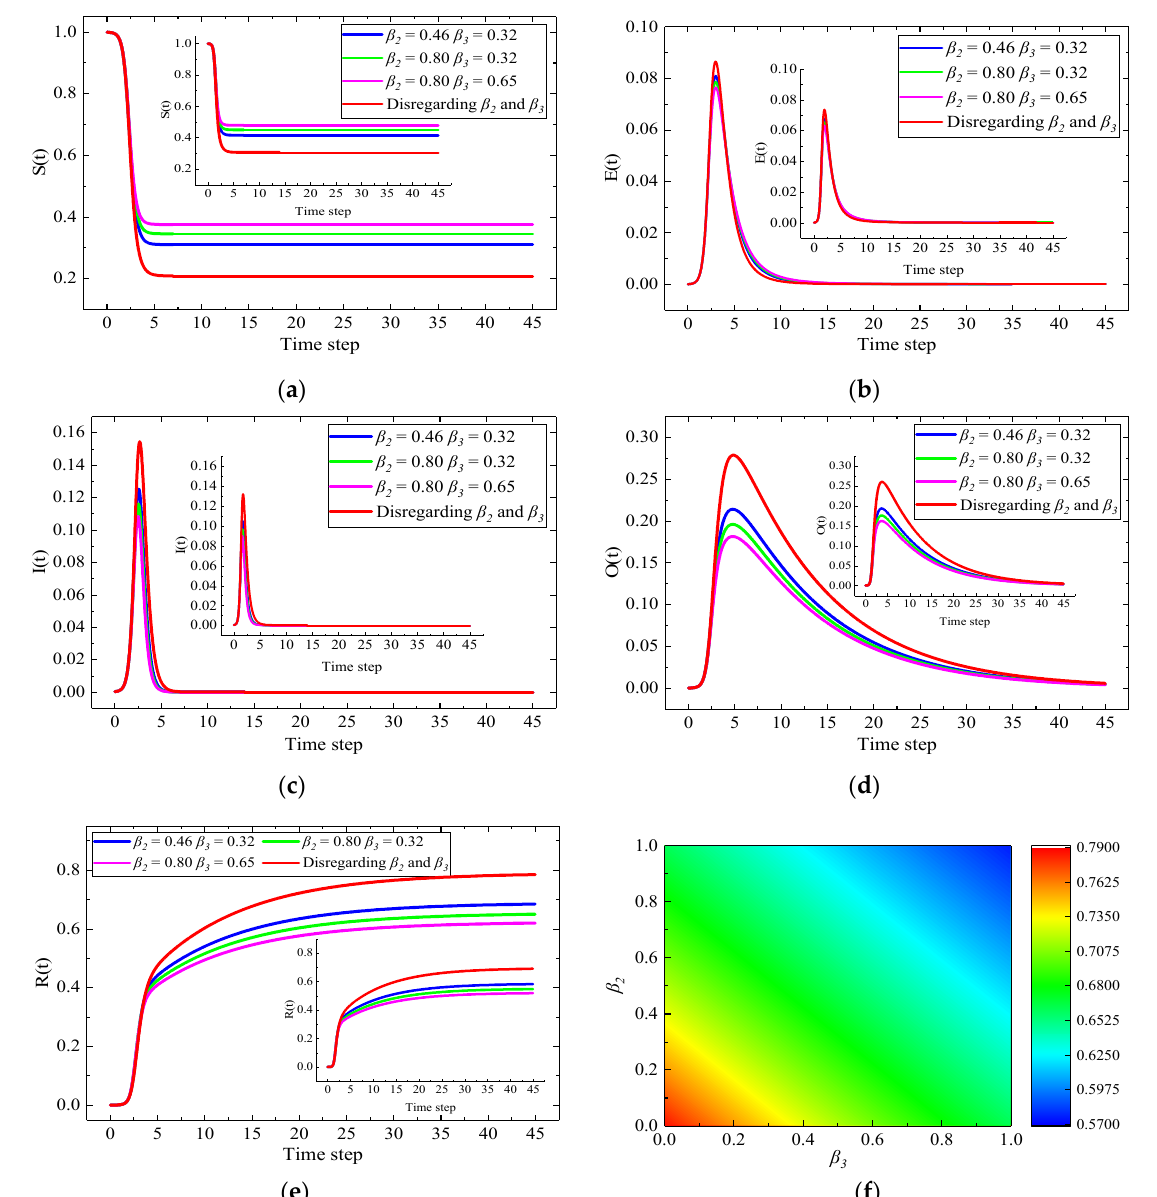
Figure 8. ( a – e ) show the density evolution curves of ignorant people, hesitators, spreaders, rumor debunkers, immunizers in the two networks under different forced debunking intensities (the large figure represents the simulation on the WS network and the small figure represents the simulation on the BA network); ( f ) shows the change of the density of immunizers in the WS network with β 2 and β 3 when the time step, t = 45.